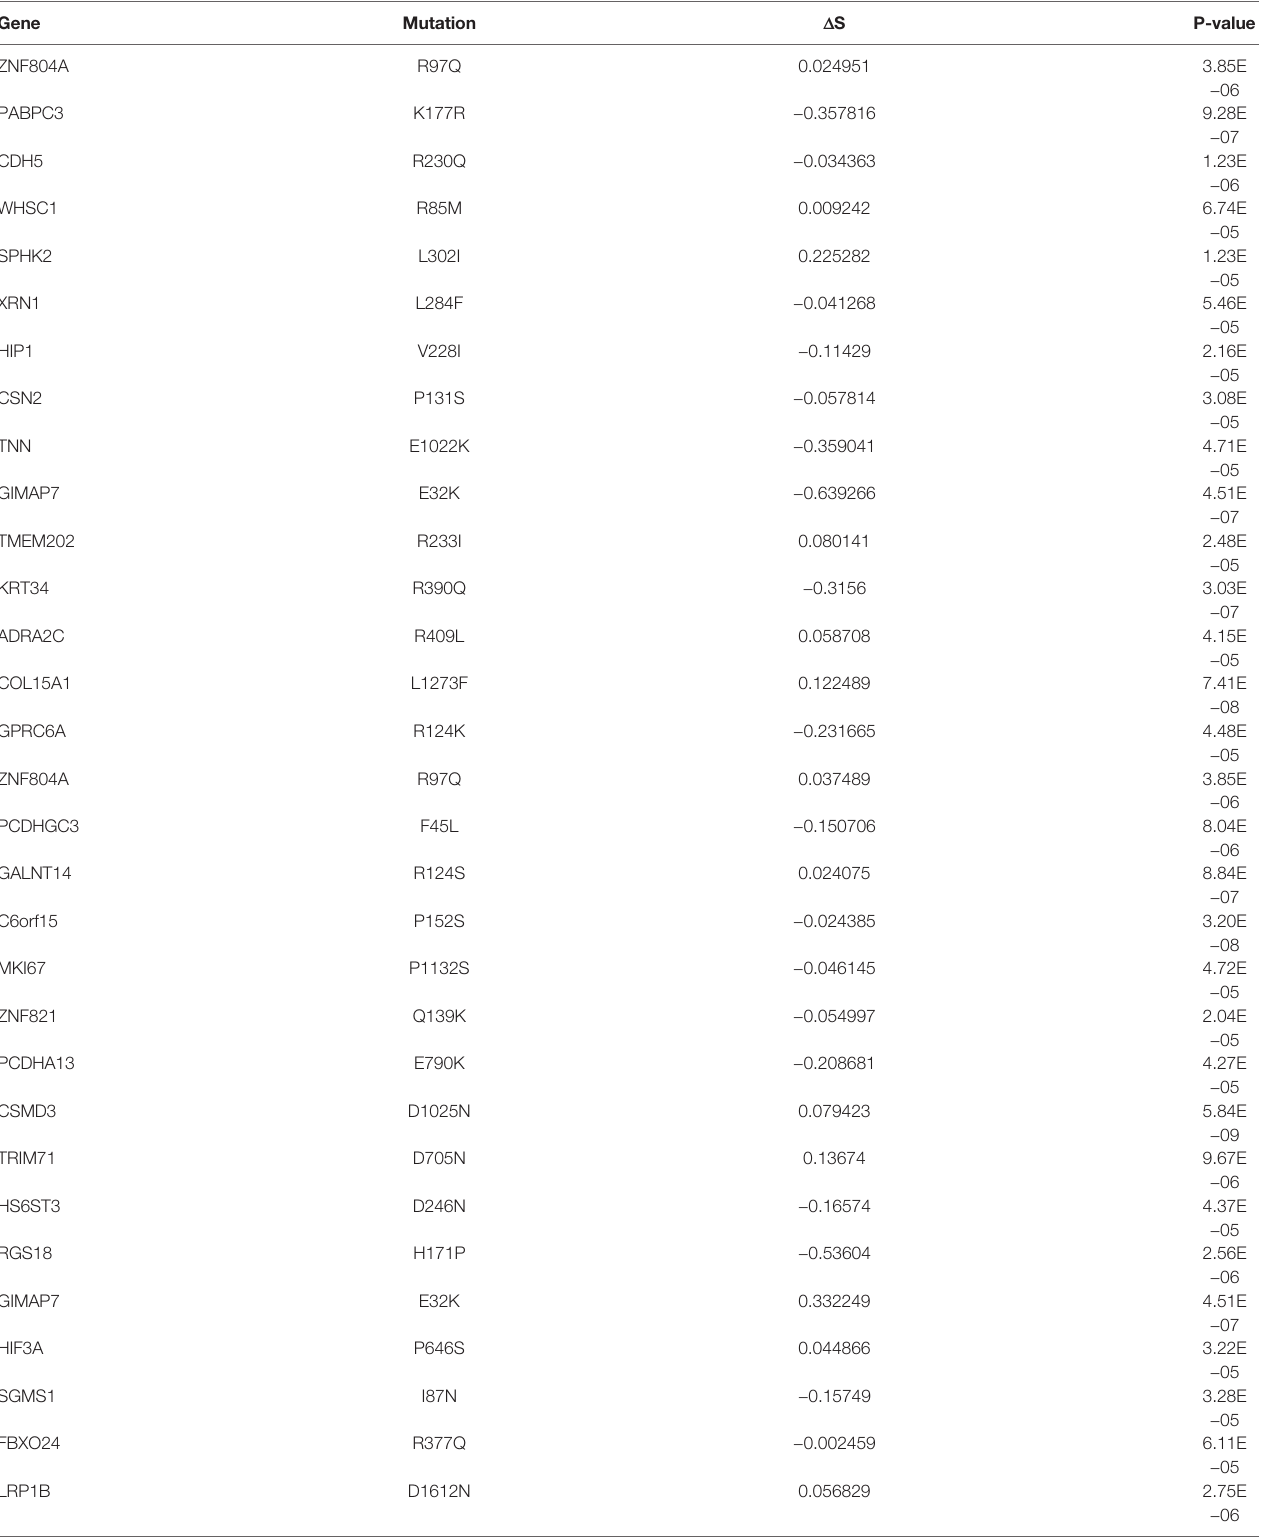
TABLE 1 | The mutations, which have signi fi cant lower D S in own patient ’ s HLA alleles than non-self patients ’ HLA alleles, were identi fi ed in SKCM (P-value ≤ 0.001, two-sided Wilcoxon rank-sum test).